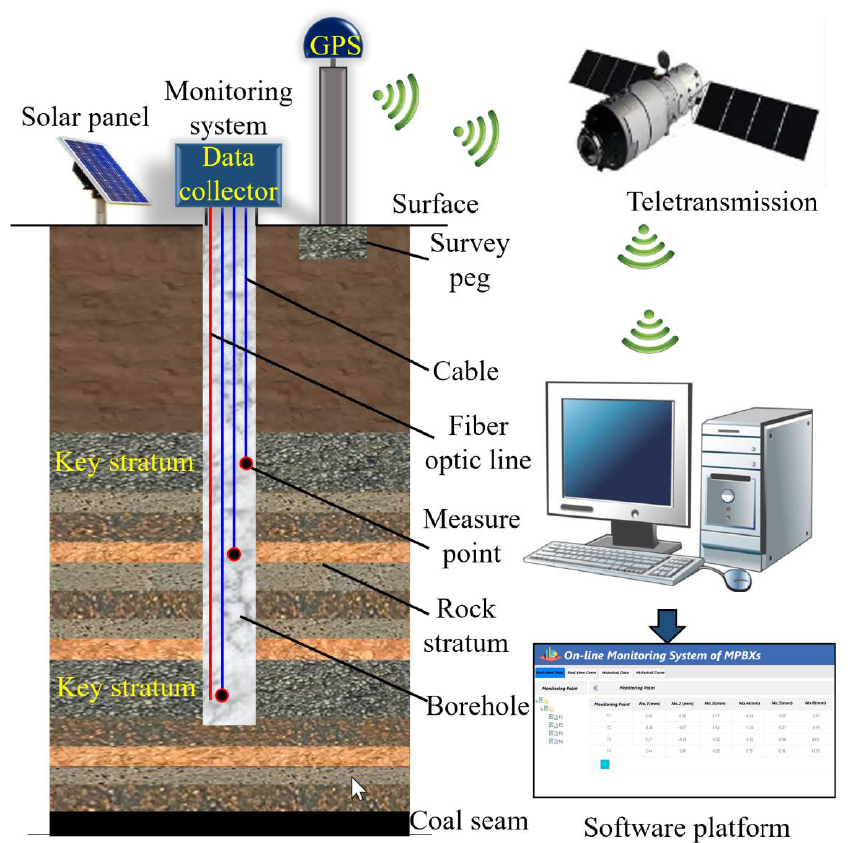
Figure 4. Schematic representation of the monitoring